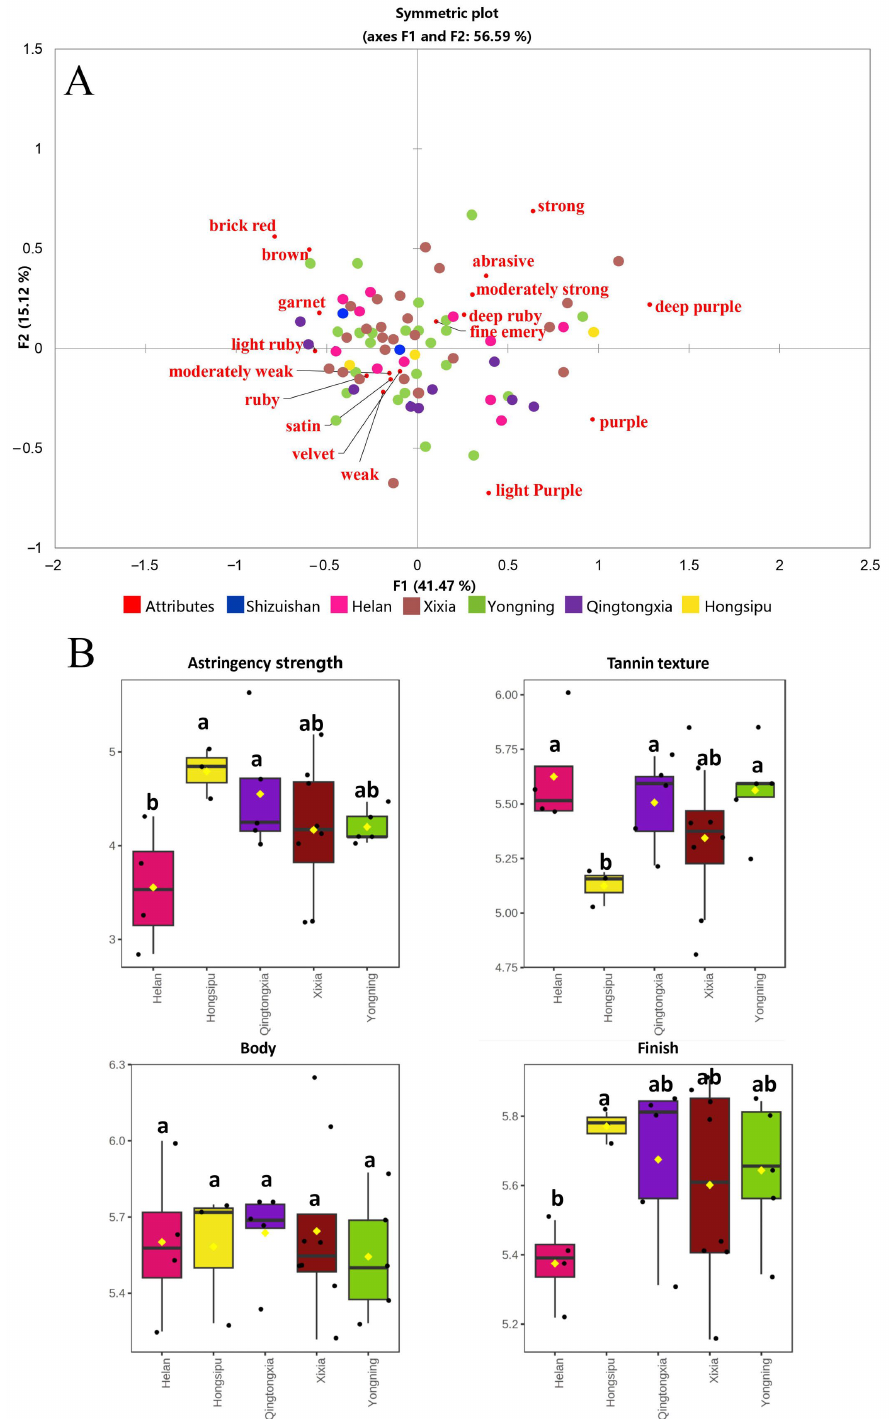
Figure 4. Sensory characteristics of Cabernet Sauvignon wines from the six sub-regions of EFHM. ( A ) Correspondence analysis of wines based on CATA; ( B ) Box plot of wines based on QDA. Different letters in the same area indicate significant difference ( p < 0.05) using Duncan’s multiple range test.